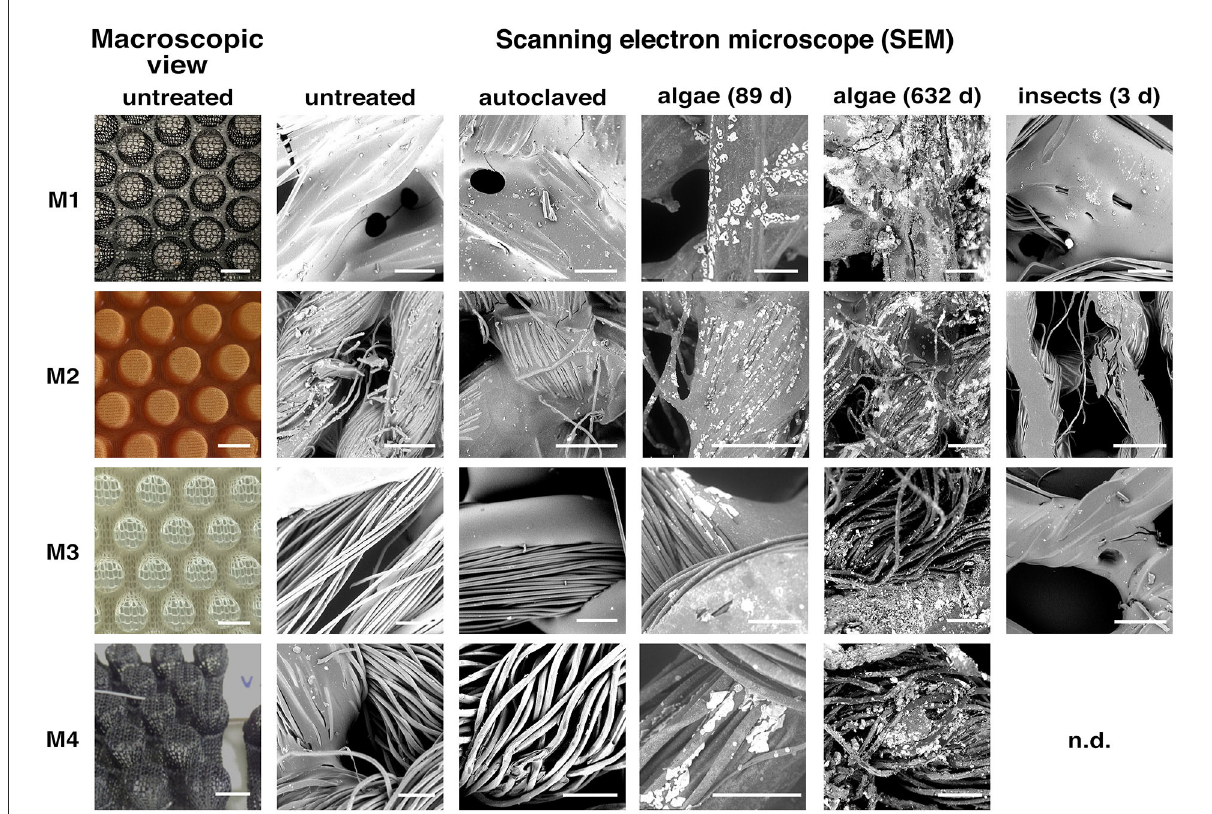
FIGURE1 SEM images of experimental materials (M1–M4). Microscopic images taken with a scanning electron microscope (SEM) at a magnification of X1000 at high dynamic range. Showing material before (untreated) and after physical pressure (autoclaved) and exposure to the marine macroalgae Ulva fenestrata (Algae) for a period of 89 days (left) and 632 days (right) at 3.5% salinity at 16 ◦ C and crickets Acheta domesticus (Insect) for a period of 3 days at 32 ◦ C and 70% relative humidity. Scale bar size in macroscopic views of materials (first column) is 1cm length and in detail view of materials is 200 µ m length. n.d. indicate missing material in insect